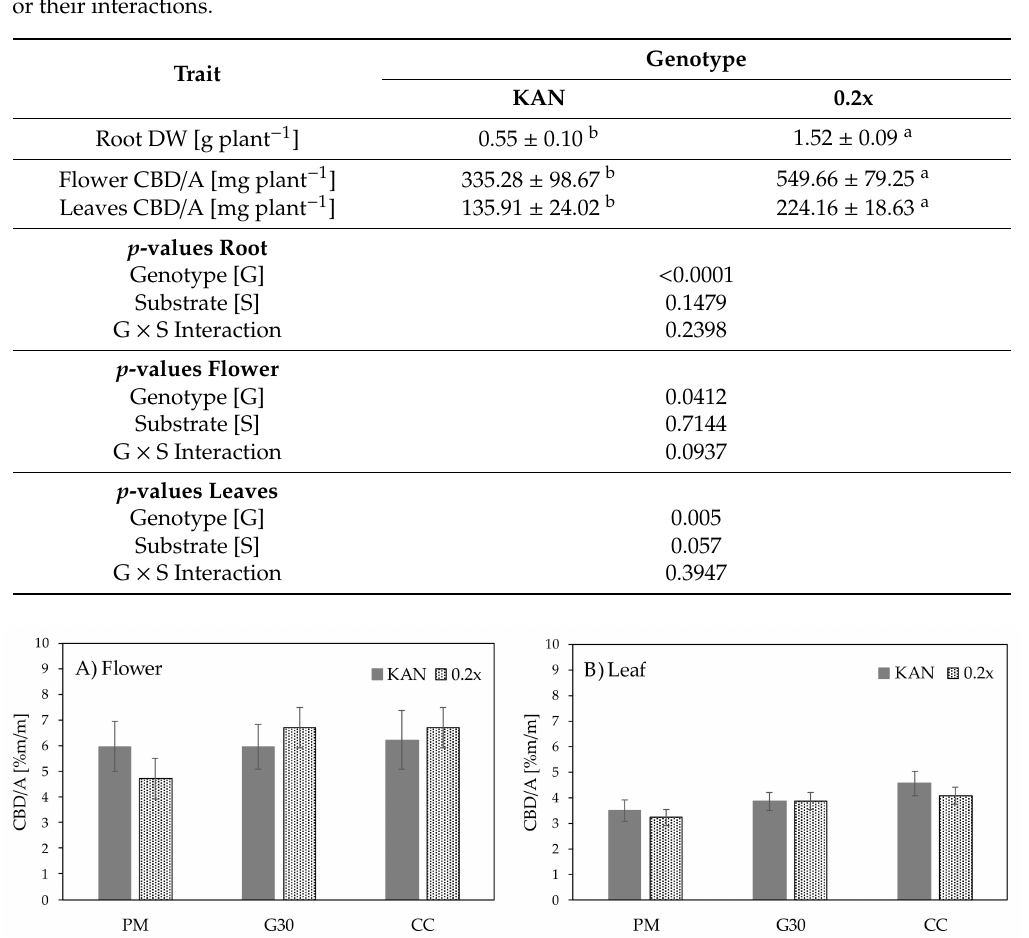
Table 5. Mean root DW in g plant − 1 and mean CBD / A yields in mg plant − 1 of genotypes KAN and 0.2x, grown on peat-mix (PM), peat-mix + 30% green fibre (G30) and 100% coco coir fibre (CC) substrates. Results are presented as mean values ± standard error (Mean ± SE). Letters compare the mean DW yield of root and CBD / A yields of flower and leaf. Means in one row followed by at least one identical lower-case letter are not significantly di ff erent as indicated by Tukey’s test ( α = 0.05). The p -values correspond to global F tests for the di ff erence between the levels of the mentioned genotypes, substrates or their interactions.